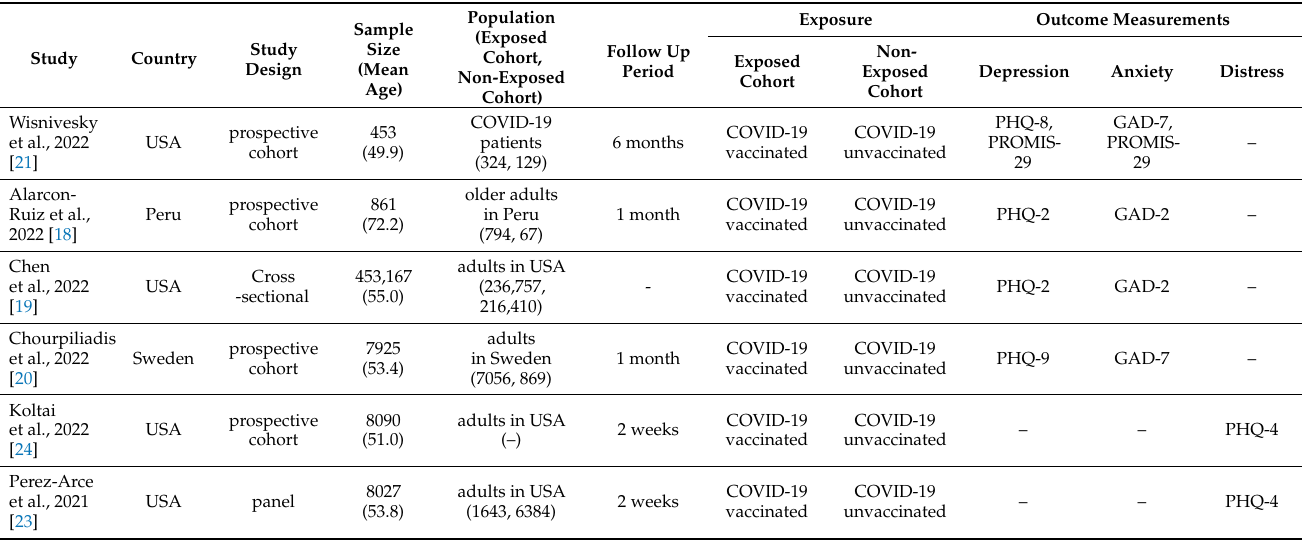
Table 1. Characteristics of included studies.